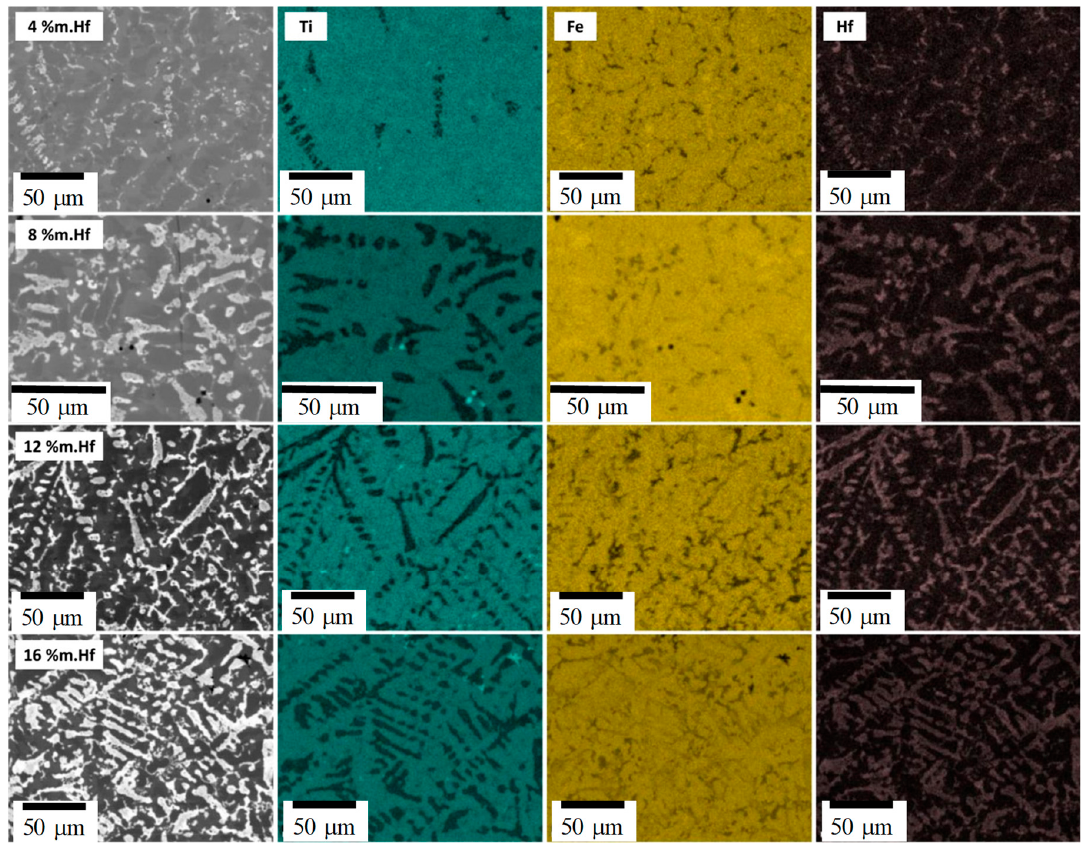
Figure 3. BSE images of the TiFe + x Hf alloys (with x = 0, 4, 8, 12, and 16 wt.%) and EDS (Energy Dispersive Spectra) elemental maps of Ti, Fe, and Hf. Bright colors indicate a high content of the element, dark areas mean low abundance.